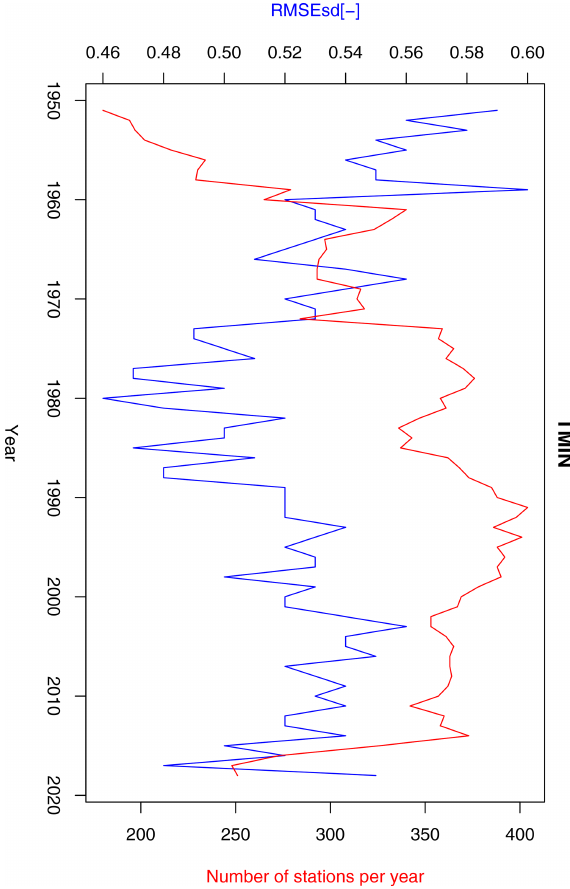
Figure 13. Annual RMSEsd median (blue) and number of available stations per year (red) for minimum temperature in the period 1951– 2019. The daily results, also summarized in Table 1, were used for calculating the annual